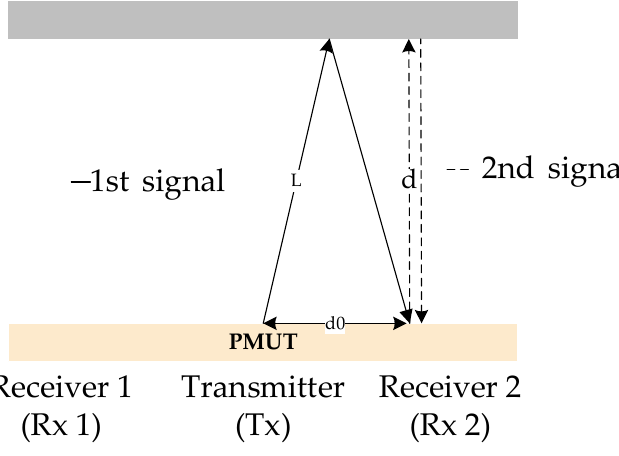
Figure 9. Schematic of the proposed ultrasonic path calibration.